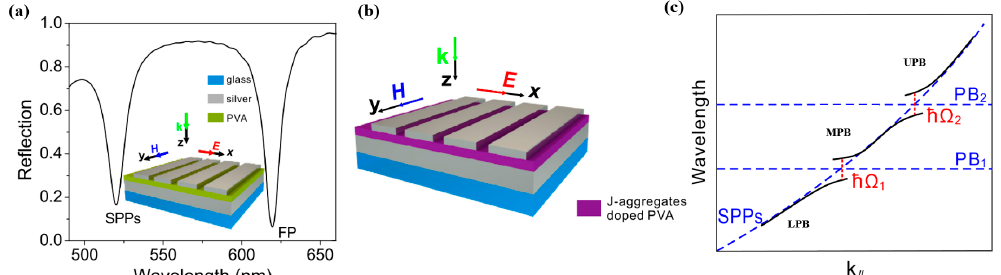
Figure 9. ( a ) The calculated reflection spectrum of the nanostructure with PVA inserted between a silver grating and a thick silver film. The inset gives a schematic description of the nanostructure. ( b ) A schematic description of the TDBC J-aggregates doped nanostructure. ( c ) Sketch of the interactions among SPPs mode, PB1 mode, and PB2 mode. Adapted with permission from Ref. [132]. Copyright 2016 American Institute of Physics.